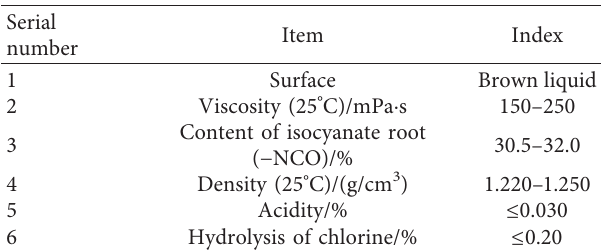
Table 2: WANNATE PM-200 physicochemical property.